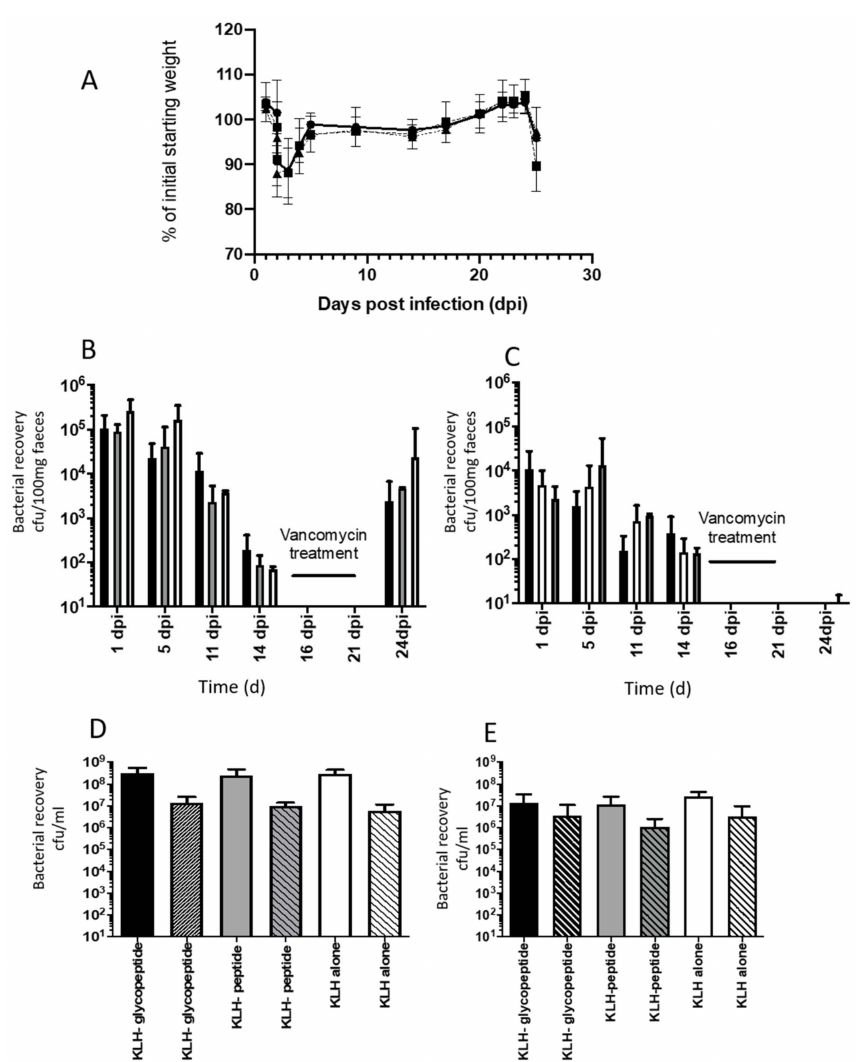
Figure 8. Impact of intranasal vaccination of mice with KLH peptide conjugates + CT on acute and relapsing C. di ffi cile disease. ( A ) represents changes in average percentage (%) change in the weight of the mice following C. di ffi cile challenge. Each point presents the average weight of animals immunized with either KLH-glycopeptide + CT (circle), KLH-peptide + CT (inverted triangle), and KLH + CT alone (black square). Error bars represent the standard deviation of the mean for 8–9 mice per group. ( B ) reflects the recovery of both vegetative and spores in the feces of mice on days post challenge with C. di ffi cile (days post infection, dpi). The mean bacterial recovery (cfu / 100g of feces) from animals immunized with KLH-glycopeptide + CT (black square), KLH- peptide + CT (grey square), and KLH + CT (white square) from 8–9 mice per group is shown. Error bars represent the standard deviation from the mean. ( C ) represents analysis of the spores within the samples highlighted in Figure 6B and were calculated by from serial dilutions of samples following treatment of these samples at 65 ◦ C for 30 min. ( D ) represents the recovery of C. di ffi cile from caecal samples collected at the experimental endpoint on day 25. Mean bacterial total counts from 8-9 animals immunized intranasally with KLH-glycopeptide + CT (black square), KLH-peptide + CT (grey square), or KLH + CT (white square) are shown in single blocked colors and spore counts from the same groups are highlighted by patterned blocks. Error bars represent the standard deviation from the mean of these counts. ( E ) represents the equivalent recovery of C. di ffi cile from colonic samples from the same animals, with total recovery of C. di ffi cile represented by solid blocks of color and spore counts by patterned blocks. Error bars represent the standard deviation from the mean of these